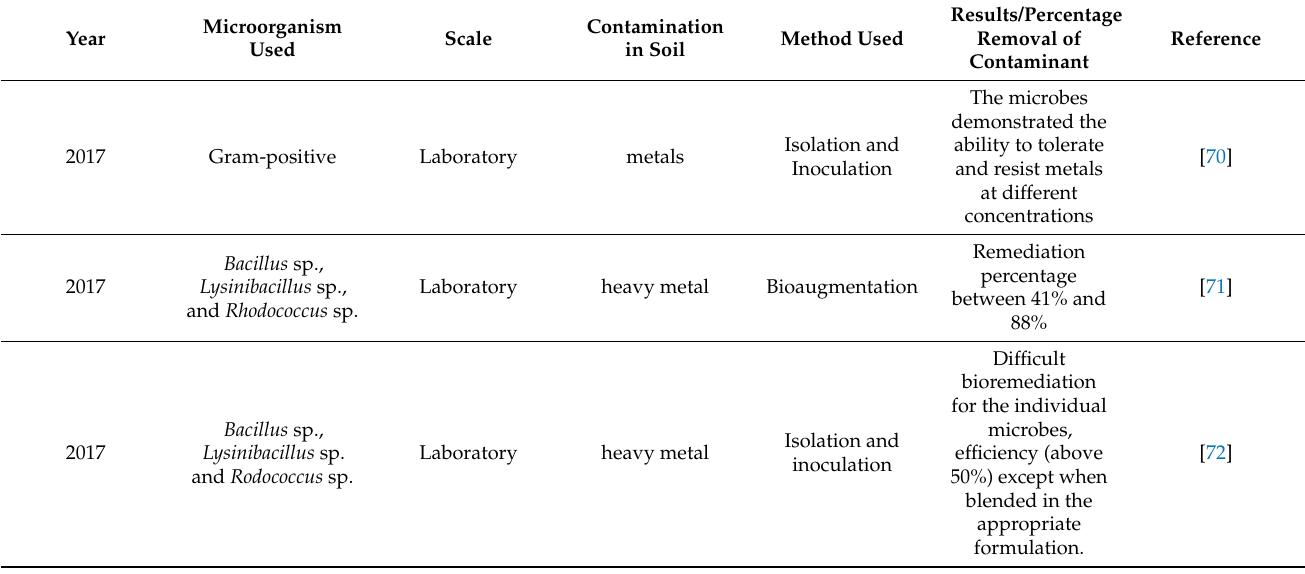
Table 2. The removal rate of Heavy